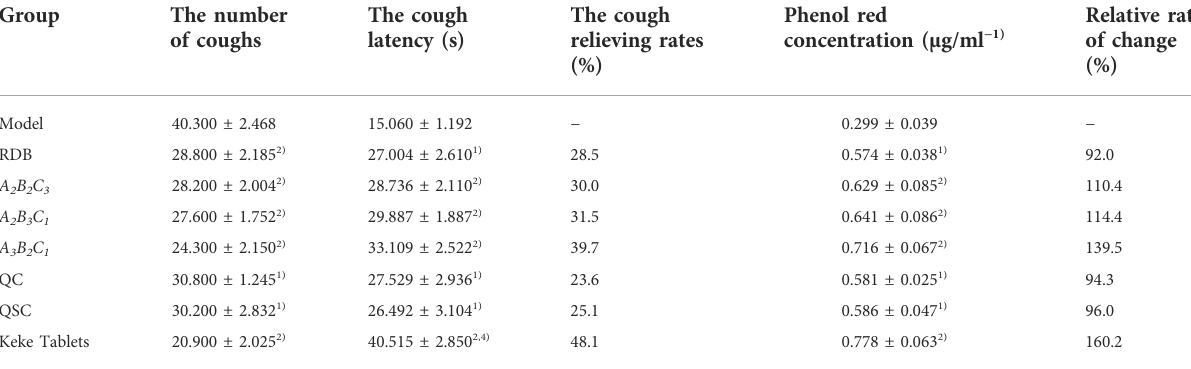
TABLE 9 Processing with ASR conserved the antitussive and expectorant ef fi cacy of RDB.